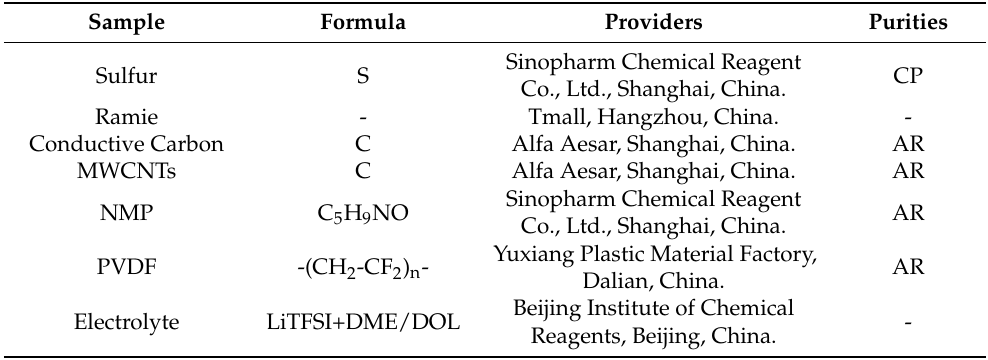
Table 1. Experimental reagents.